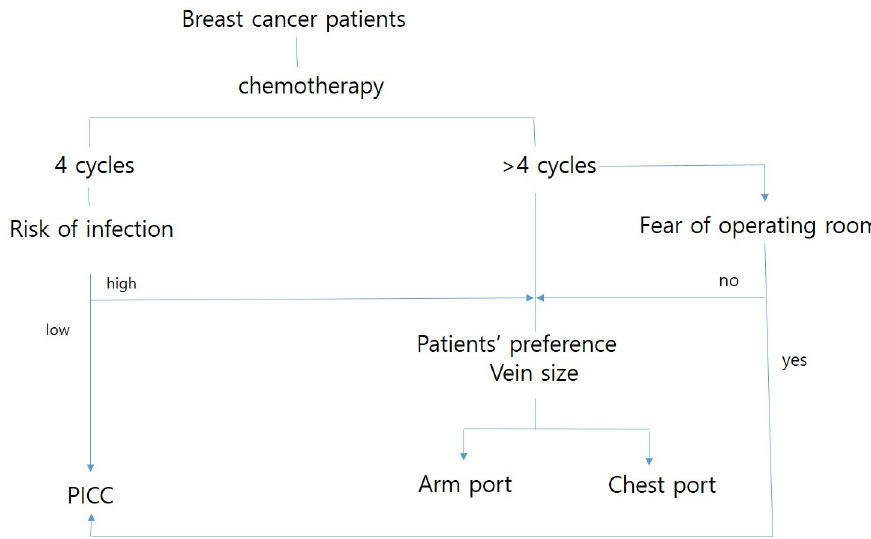
Fig 1. Decision algorithm to select the proper vascular